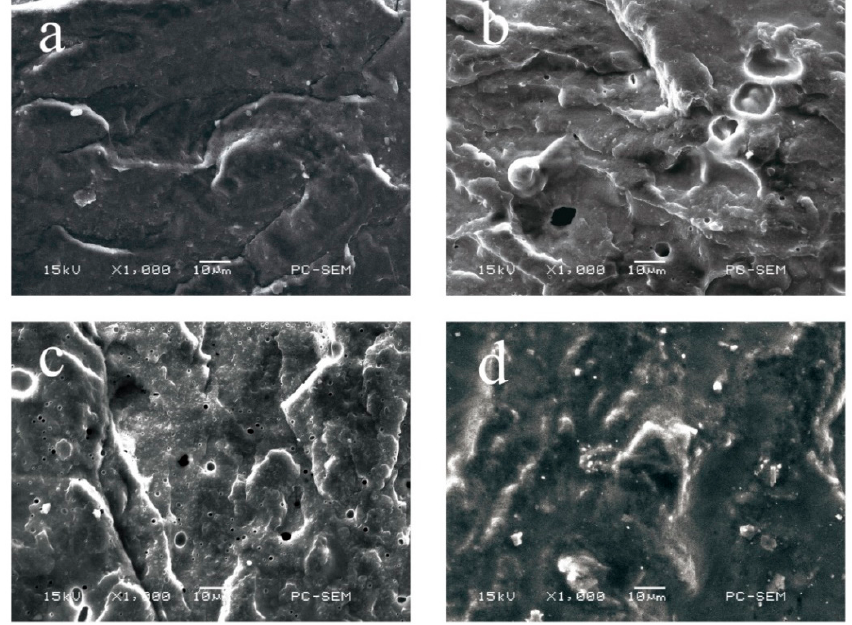
Figure 4. SEM images of the TPS/PBSA blend. ( a ) Pure PBSA; ( b ) 10% TPS/PBSA; ( c ) 30% TPS/PBSA; ( d ) 50 TPS/PBSA. ( d ) 50